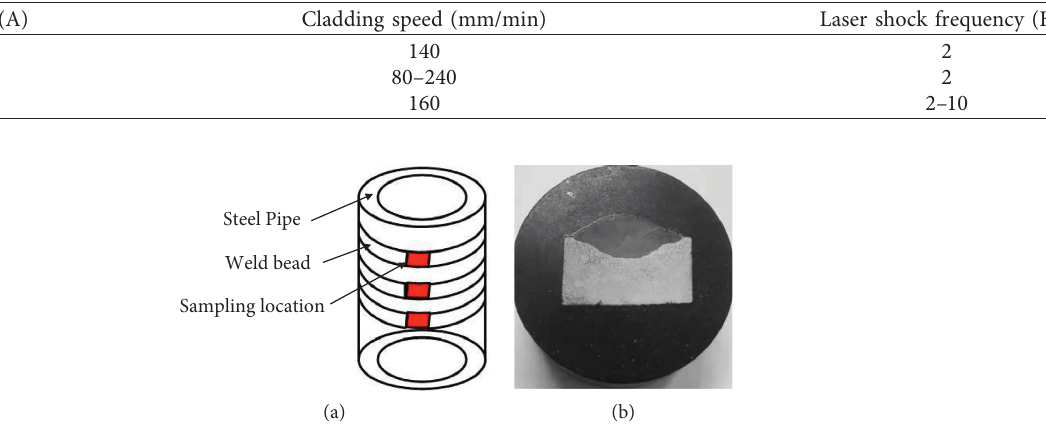
Figure 2: (a) Schematic diagram of the sampling location. (b) Digital photo of the sample after etching.